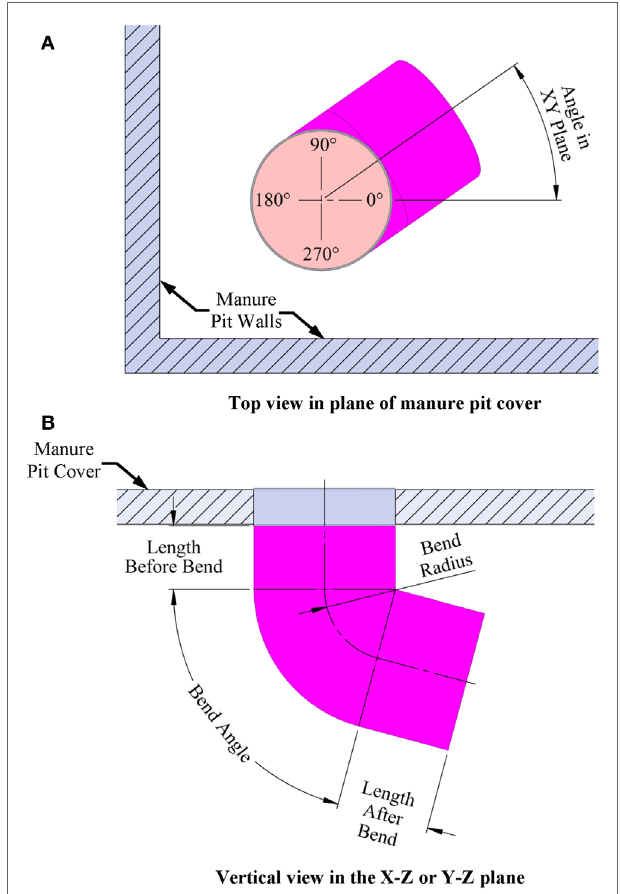
FIgURe 7 | Definition sketch for pit fan air direction controller: (A) Top view and (B) Side view .